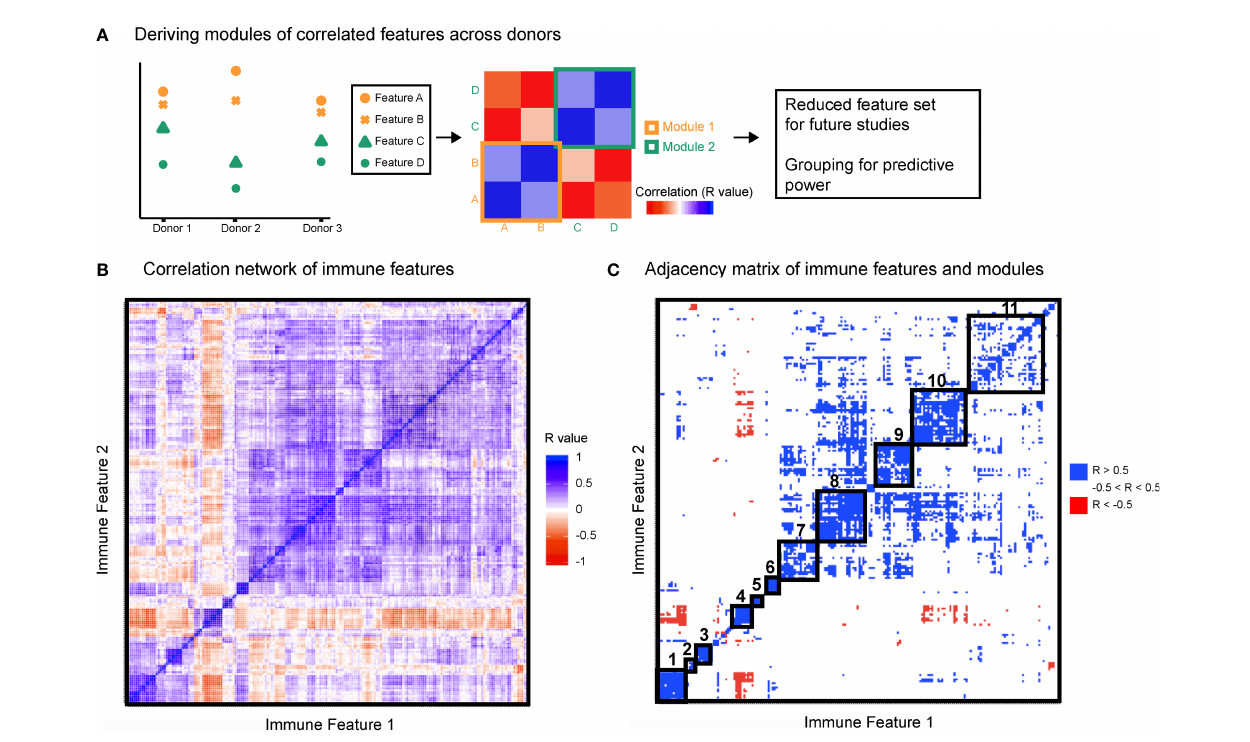
FIGURE 2 | Immune variation enables detection of response modules predominantly de fi ned by signaling proteins. All features were correlated with one another across donors. (A) Highly correlated features were identi fi ed and annotated as groups of correlated features, or modules. (B) Clustered correlation heat map of the 199 features. Immune features were clustered on each axis based on similarity of correlation coef fi cient (R-value). Heat map is colored by R-value. (C) R-values were binned yielding an adjacency matrix. R-values from -1 to -0.5 are red, R-values from -0.5 to 0.5 are white, and R-values from 0.5 to 1 are blue. Modules were drawn based on visualized groups of highly correlated features (black boxes).